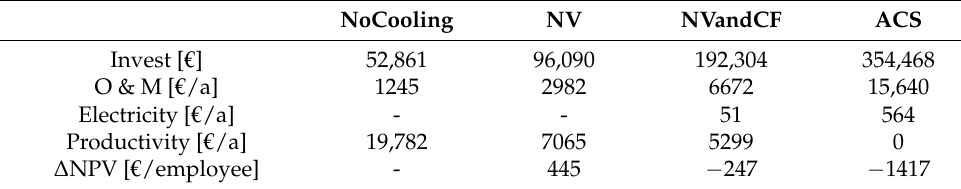
Table 12. Cost overview and the difference between NPV for all cooling